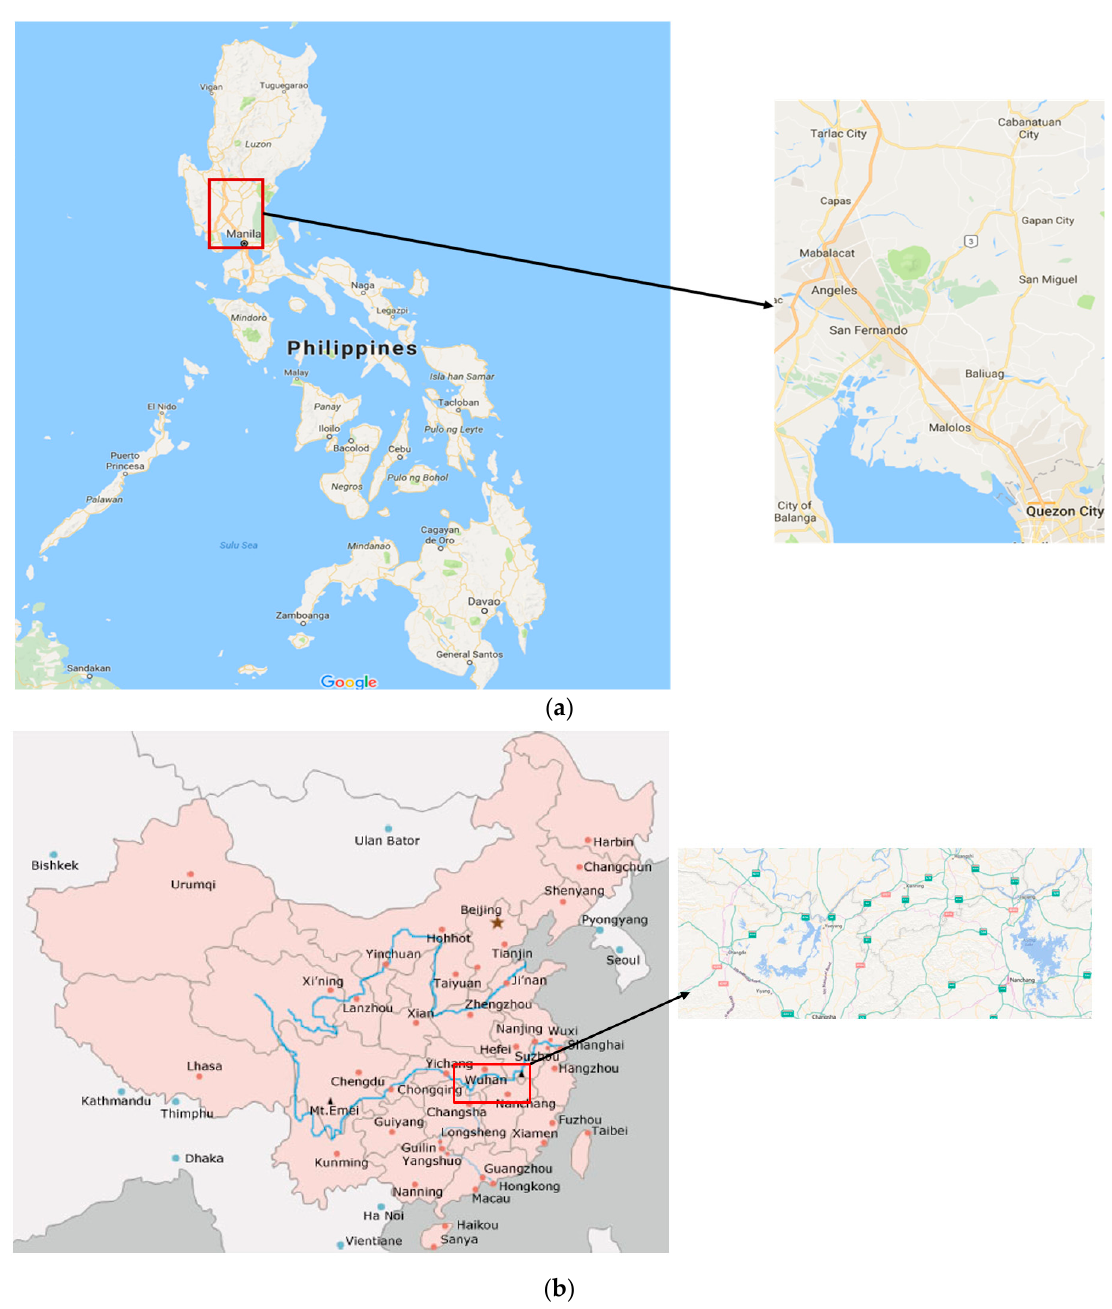
Figure 1. ( a ) Location of the Pampanga River in the Philippines; ( b ) Locations of the Poyang and Dongting Lakes in China.